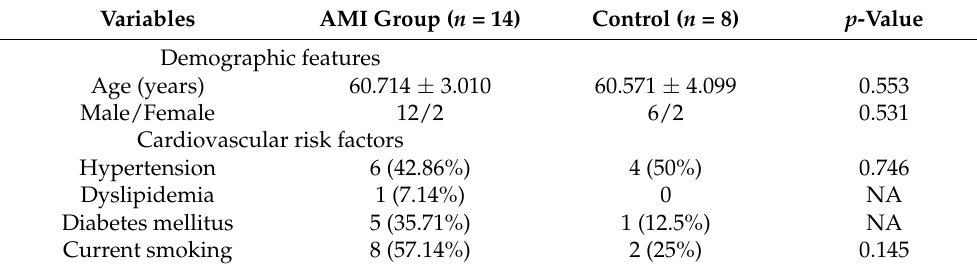
Table 3. Demographic, clinical features, and laboratory data of all the